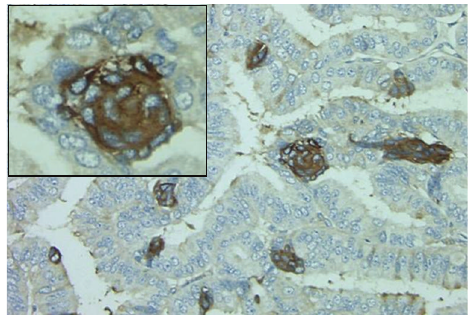
Figure 3: NP-2 expression occurs in distinct clusters of tumor cells. Representative illustration of NP-2 expression in well-di ff erentiated serous adenocarcinoma (WD). Original magnification is 100 × and inset is 200 ×